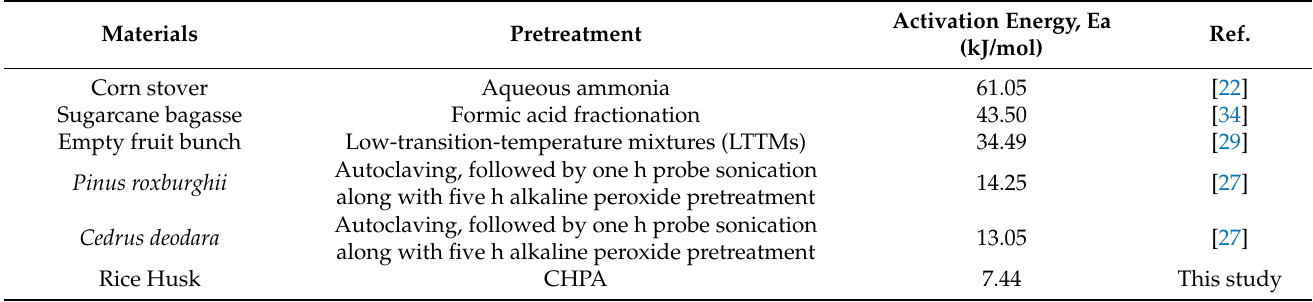
Table 4. Several authors modeled activation energies of pretreatment at different raw materials.